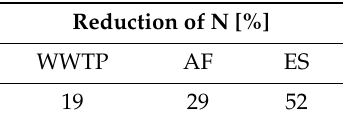
Table 2. Percentage of total nitrogen reduction at individual stages of the three-stage wastewater treatment (AF–ES–WWTP) system.